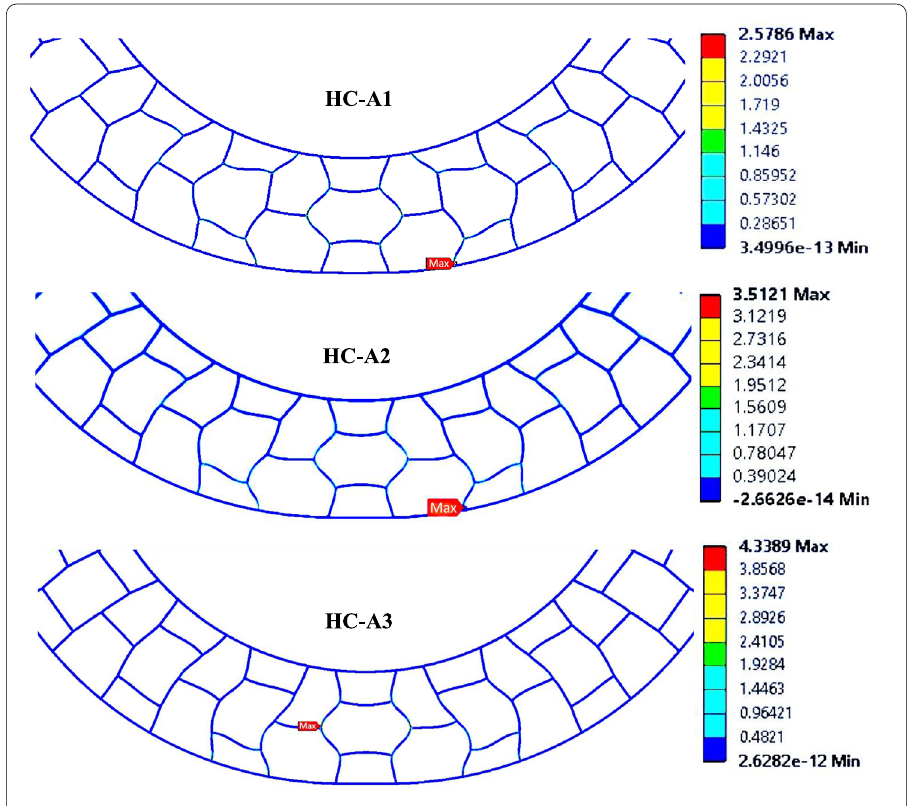
Fig. 17 Strain Energy (mJ) contours for the honeycomb NPTs at a force of 2500